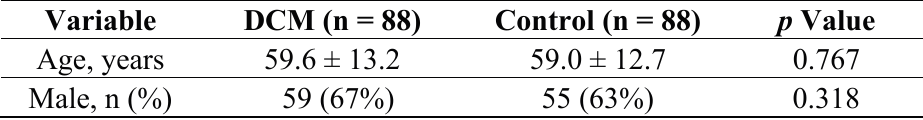
Table 1. Demographic characteristics of two groups